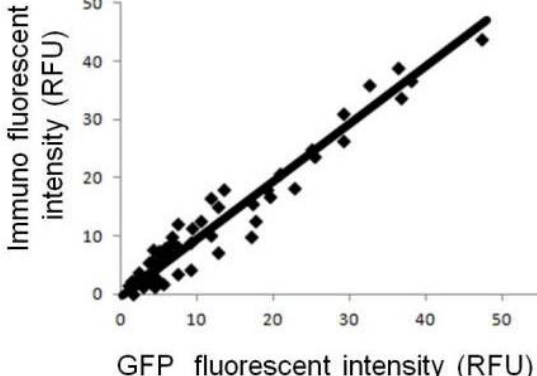
Figure 1. Relationship between fluorescent intensity of GFP and total GluR